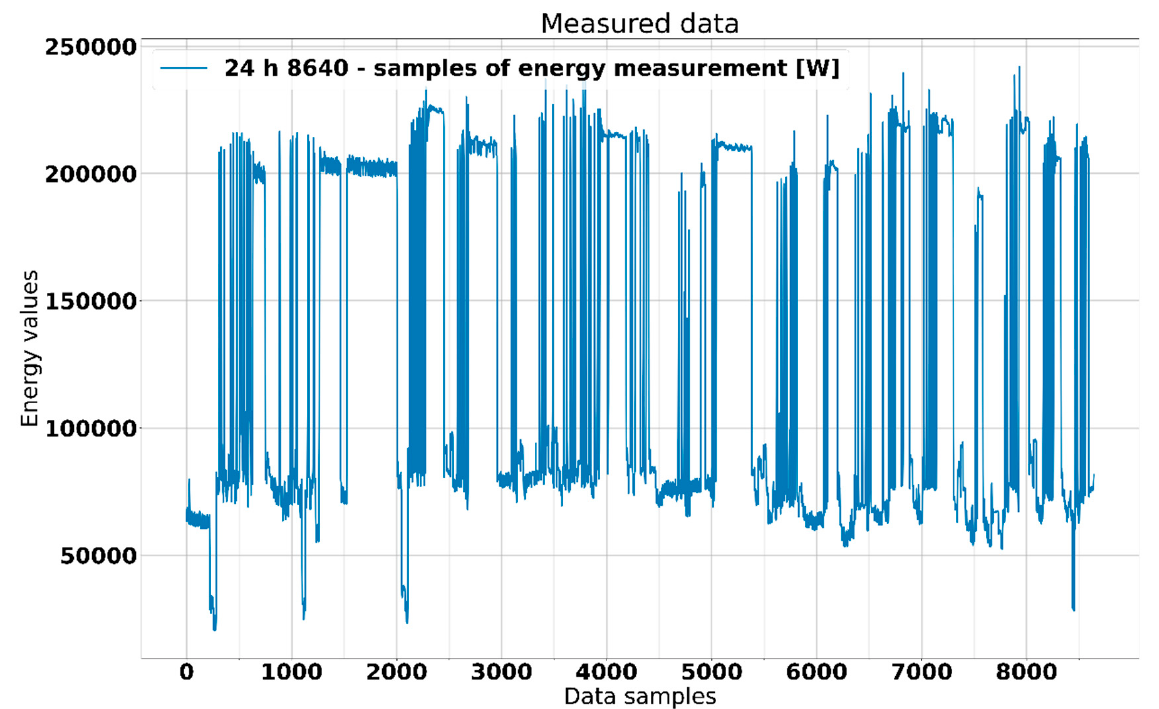
Figure 1. Measurement data graph—24 h.